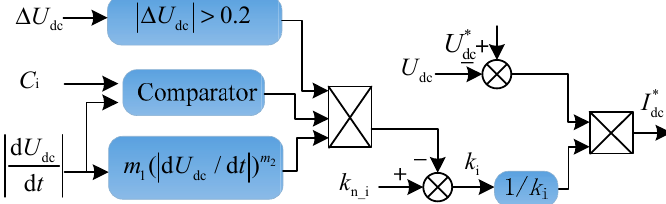
Figure 4. Principle diagram of self-adaptive inertia droop control.